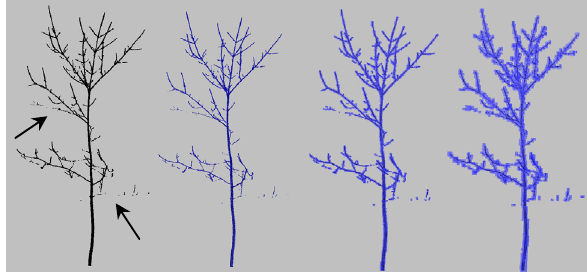
Figure 7. Steps of generalisation with missing laser scanner points due to filtering. From left to right: Point cloud of a tree; voxel spaces overlaid with point cloud (voxel size: 0.5 cm, 2 cm, 4 cm).